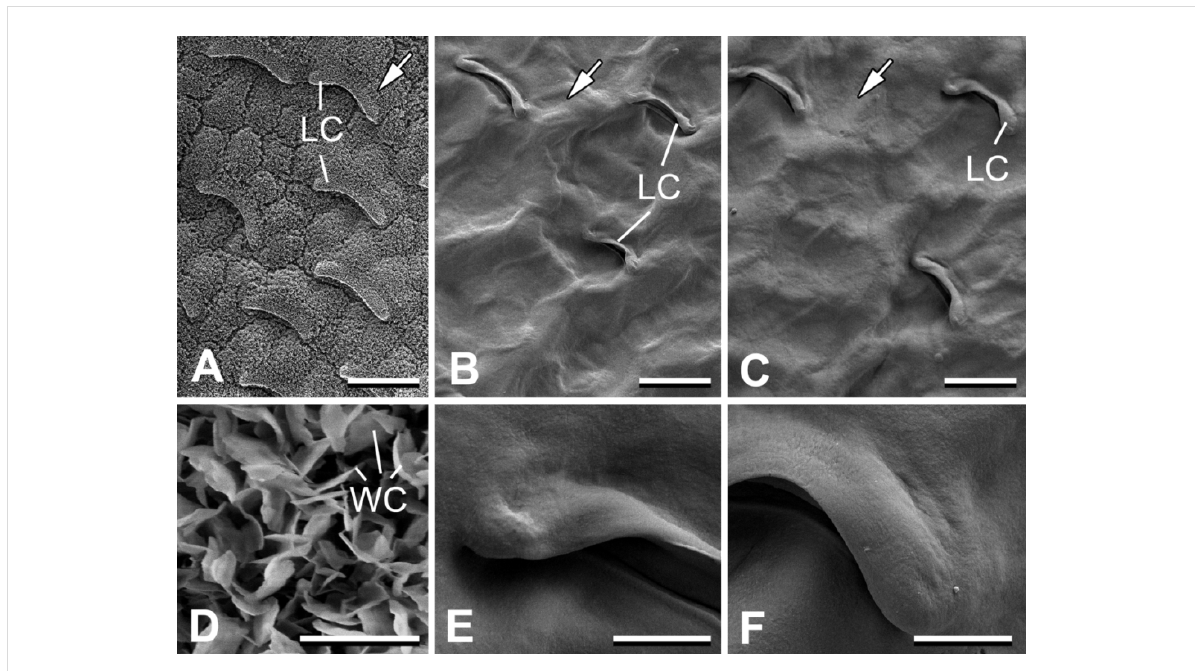
Figure 1: Cryo-SEM micrographs of intact Nepenthes alata pitchers (A, D) and SEM micrographs of de-waxed pitcher samples (B, E) and their polymer replicas (C, F) used for traction experiments. LC: lunate cells; WC: wax crystals. White arrows indicate direction to the pitcher bottom. Scale